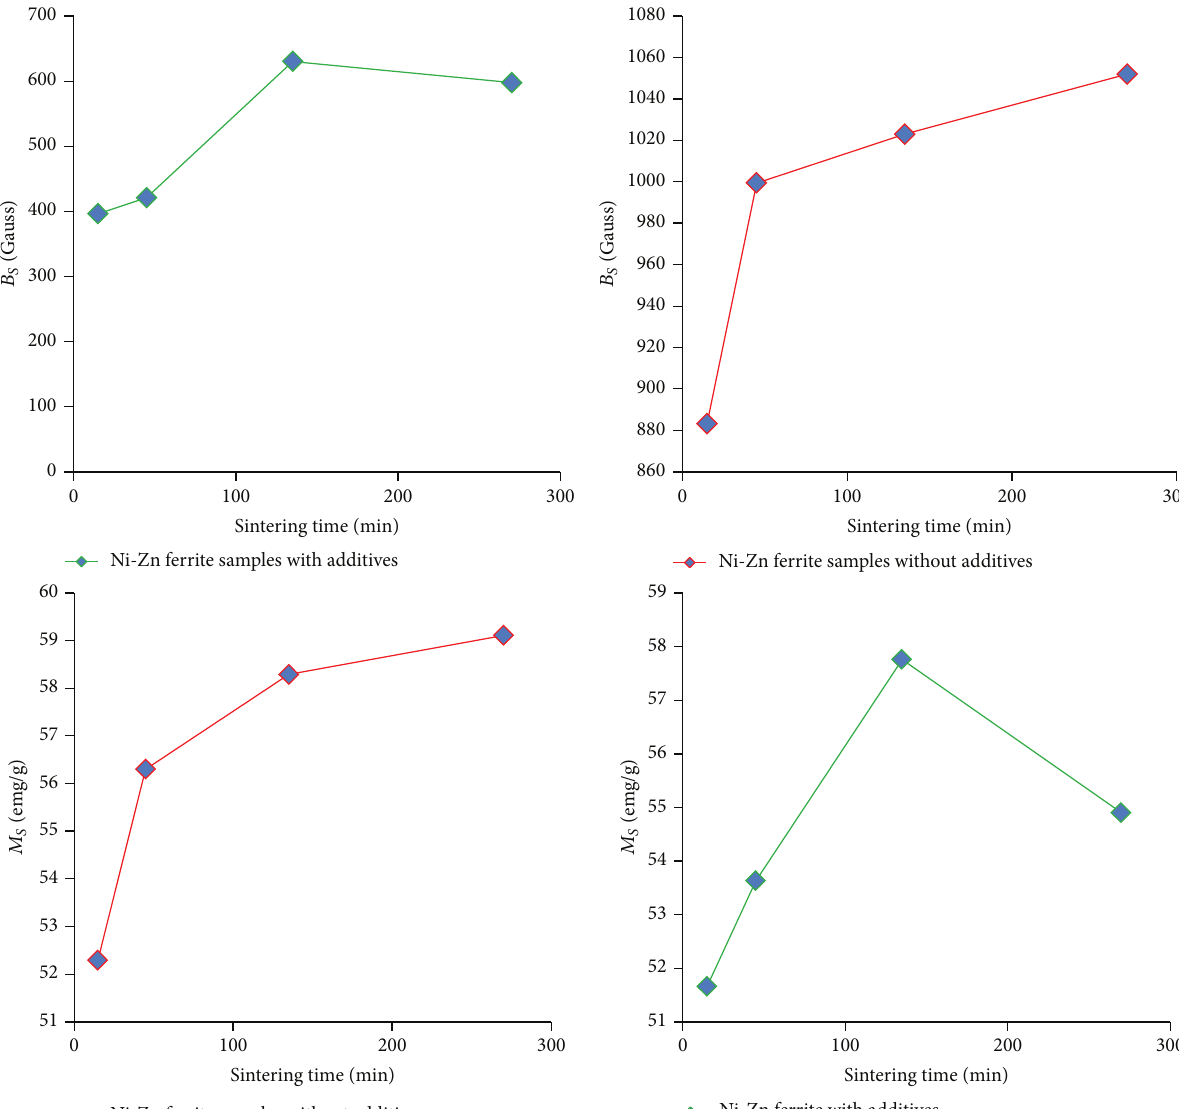
Figure 4: Variation of 𝑀 𝑆 and 𝐵 𝑆 with sintering